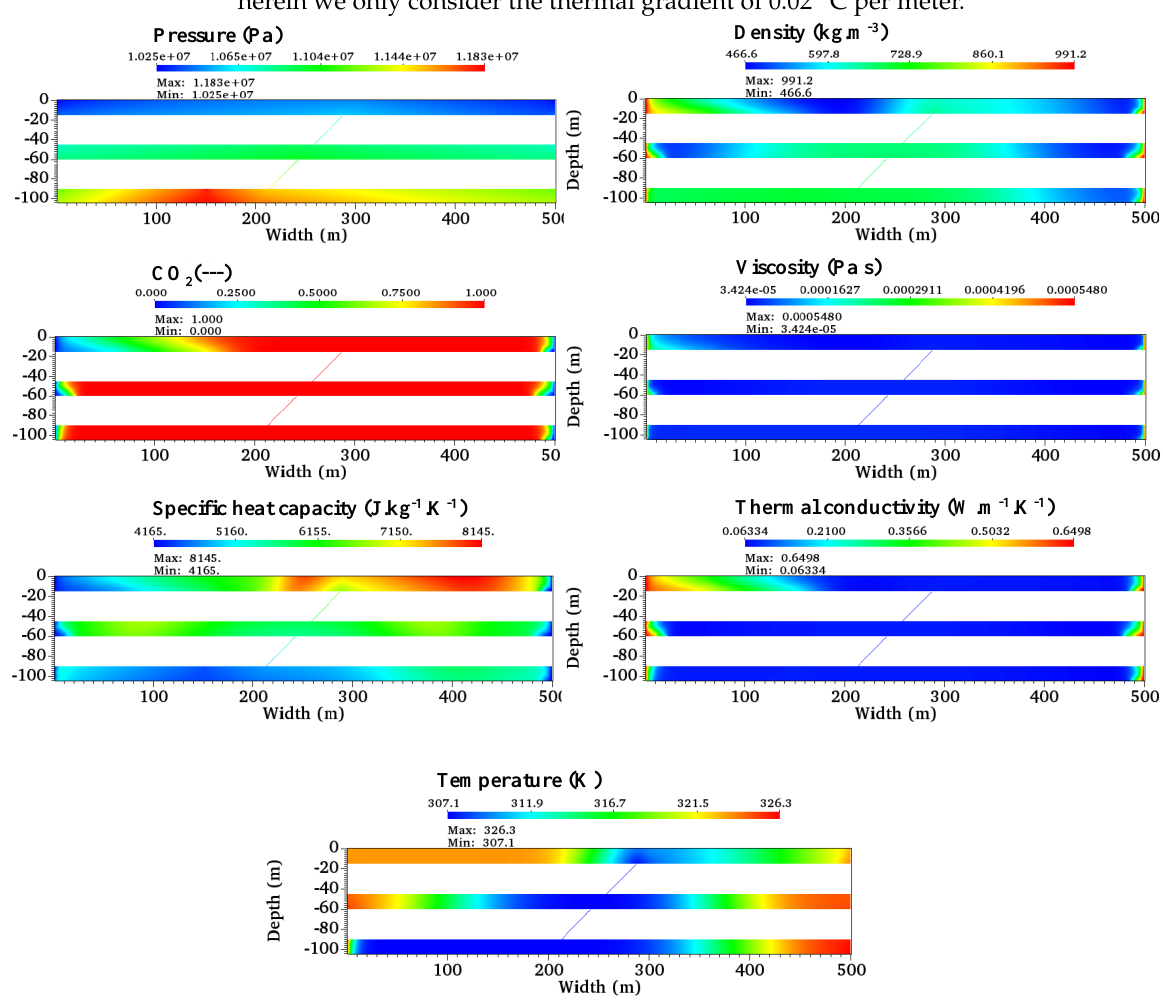
Figure 9. Distribution of pressure, density, CO 2 , viscosity, specific heat capacity, thermal conductivity,